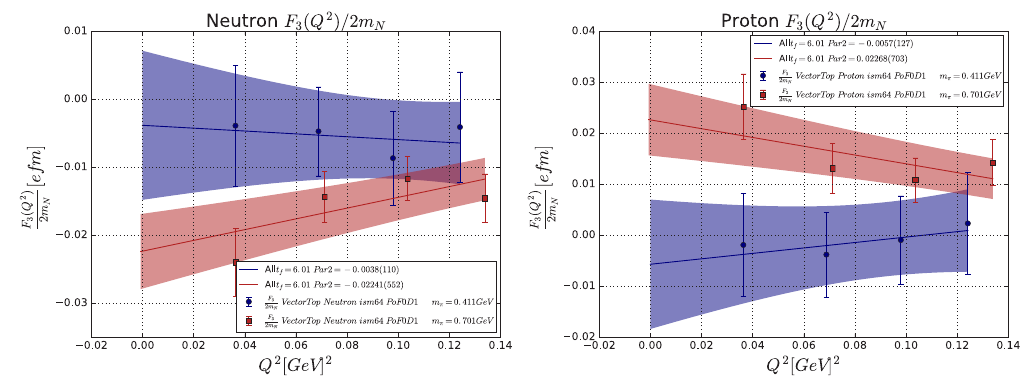
Figure 3. CP-odd vector form factor F 3 / 2 m N in units of θ for the neutron (left) and proton (right), induced via the θ -term CP-violating vacuum, plotted against transfer momentum Q 2 . Blue and red points are the m π = 411 , 701 MeV results respectively. The linear fit to Q 2 0 is used to extract the value for the neutron and proton EDM → d n / p